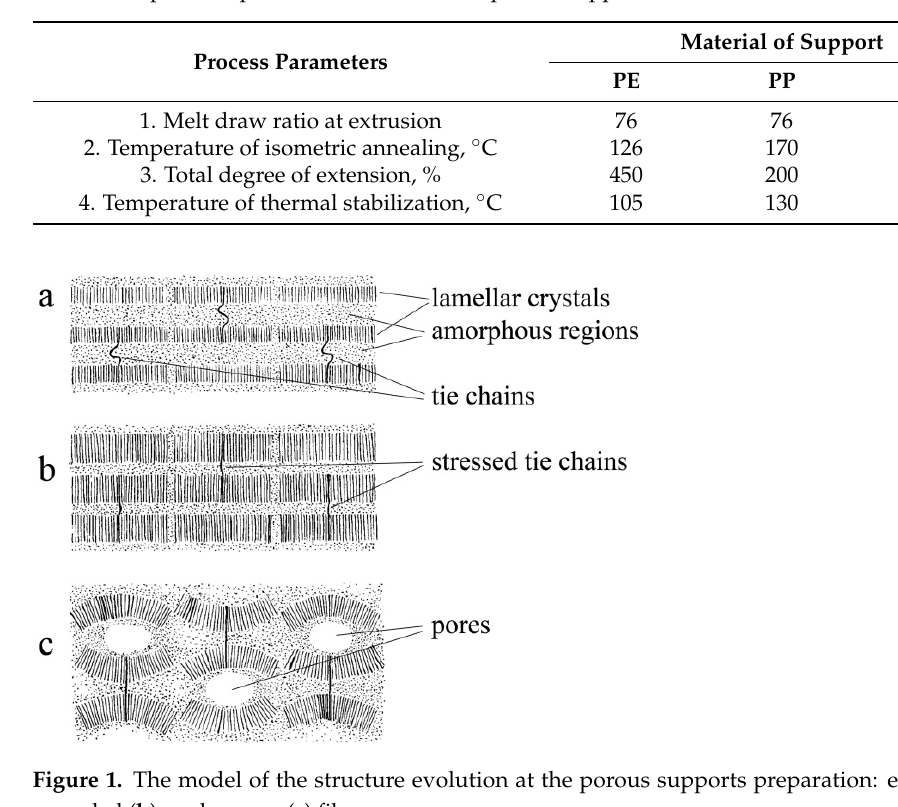
Table 1. Preparation process conditions of the porous supports.